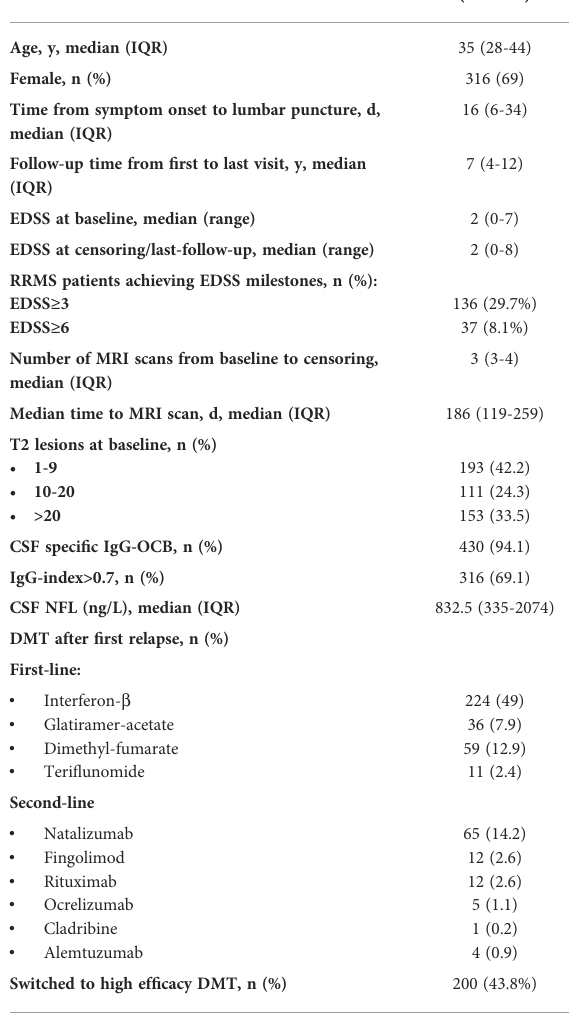
TABLE 1 Clinical and demographical characteristics of the study